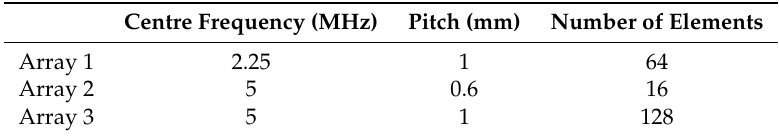
Table 1. Transducer array specifications.